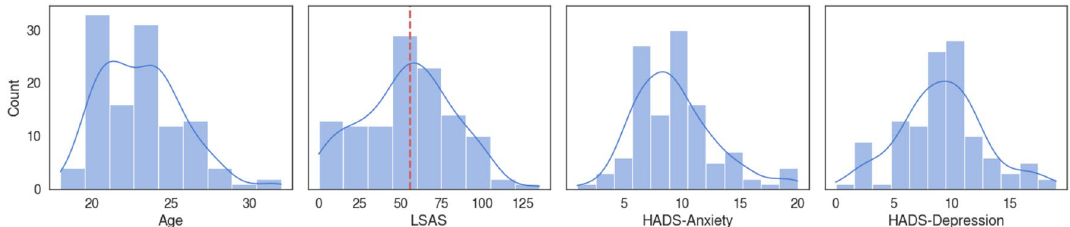
Figure 1. Histogram plot of age and psychometric scale scores of the participants. Red dotted vertical line on the LSAS plot indicates the median score (median 55.5), which served as the cutoff for separating the two groups. Abbreviations: LSAS, Liebowitz Social Anxiety Scale; HADS-A, anxiety score of the Hospital Anxiety and Depression Scale; HADS-D, depression score of the Hospital Anxiety and Depression Scale.